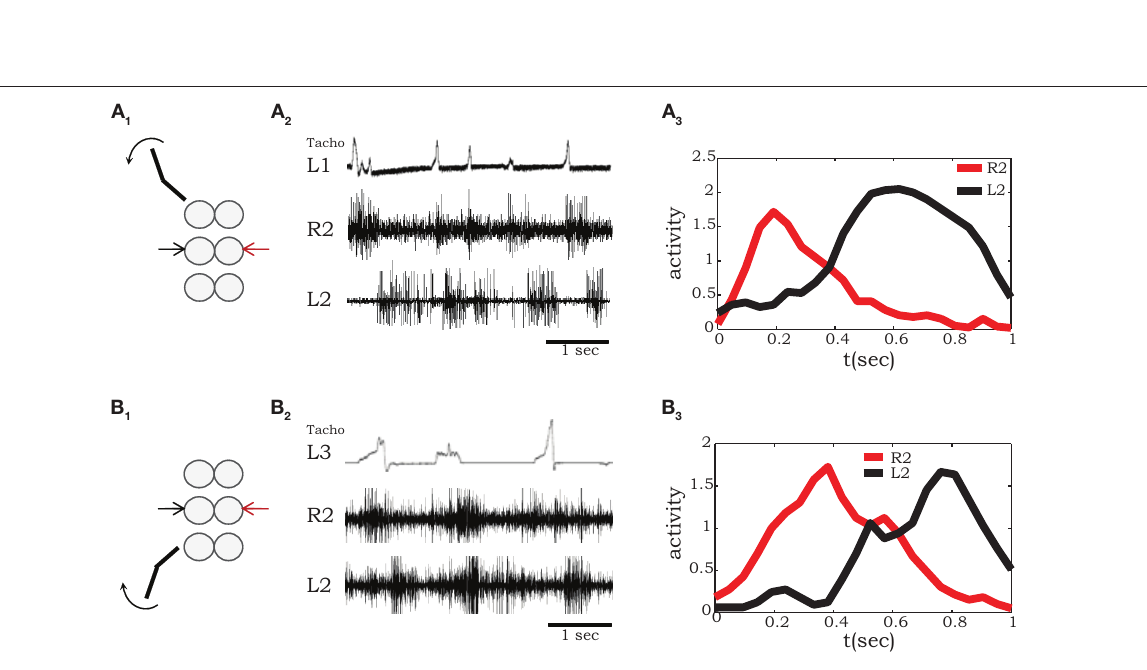
calculated from 16 sequential front-leg steps. Similarly, (B recordings from mesothoracic coxal levator MNs in a preparation with a single intact stepping hind leg (L3), while (B averaged spiking activity in contralateral (red) and ipsilateral (black) levator MNs of the mesothoracic ganglion (R2 and R3), calculated from 12 sequential hind leg